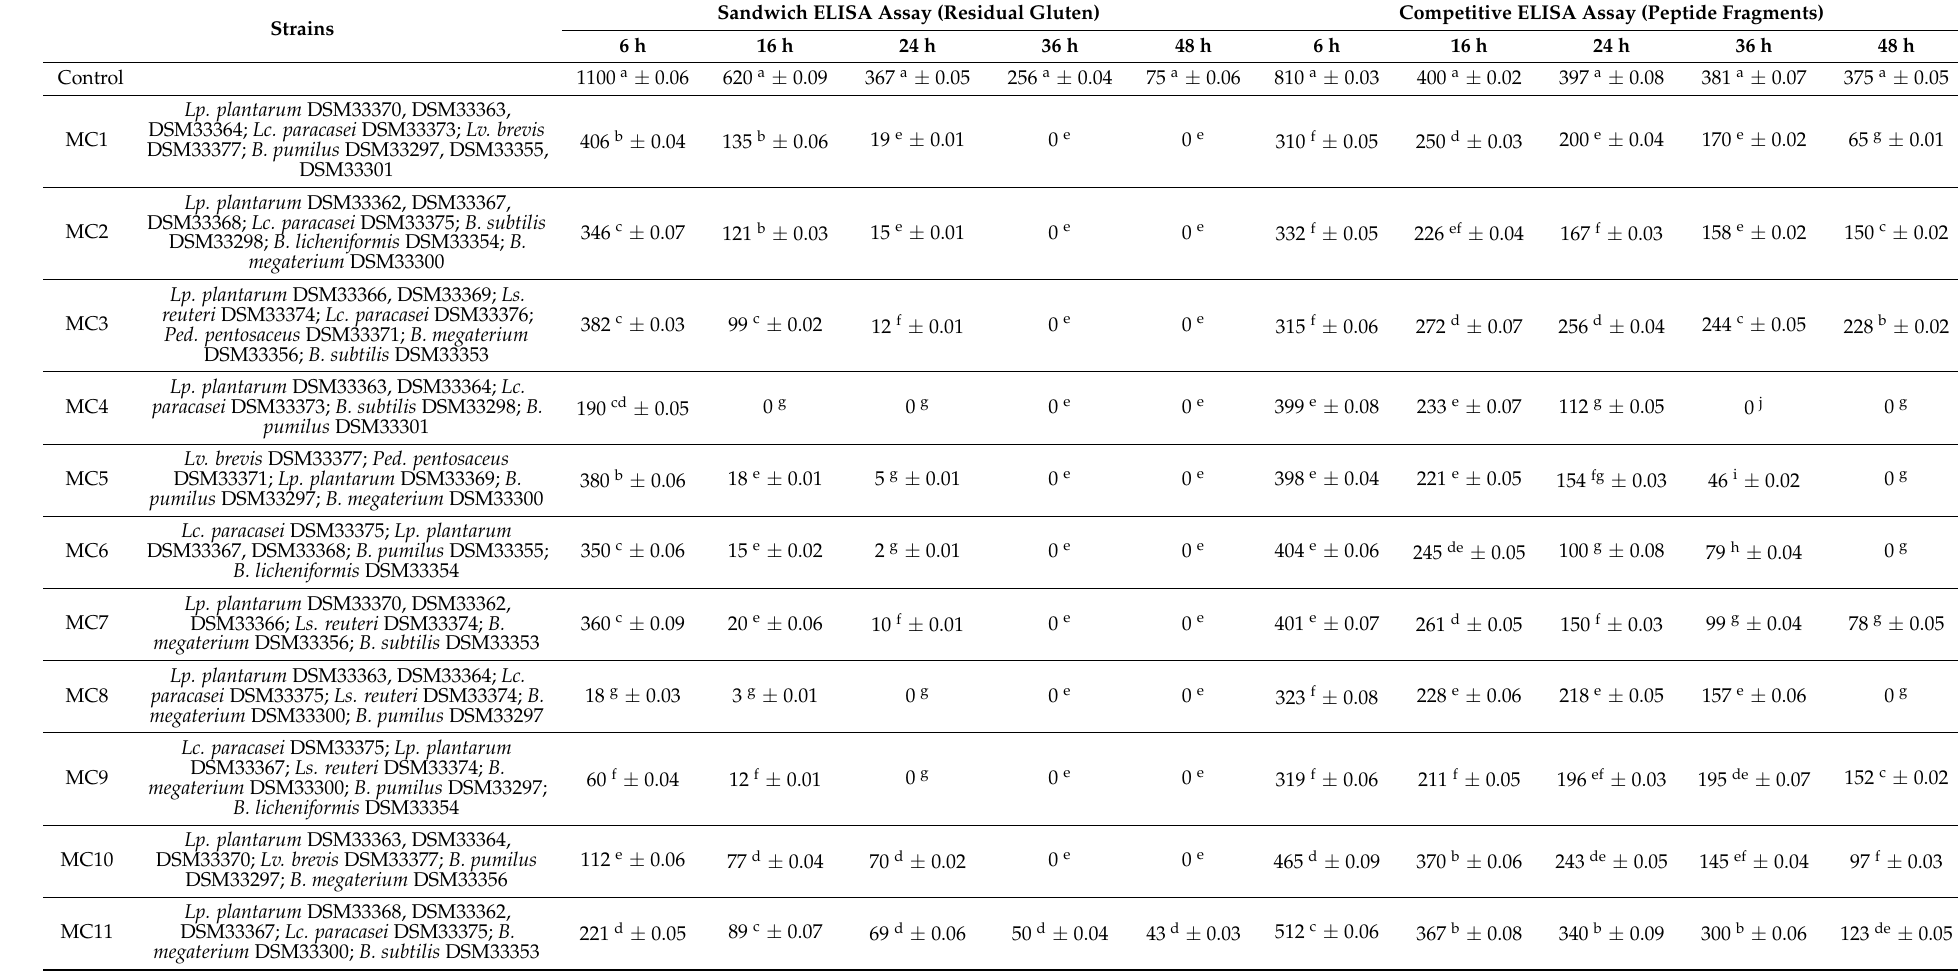
Table 1. Concentration (ppm) of residual gluten and peptide fragments of prolamins after 6, 16, 24, 36, and 48 h of simulated gastrointestinal digestion, as estimated by specific ELISA tests. Control: dough digested without bacterial cells and commercial enzymes; MC1–MC16: microbial consortia constructed by using live and lysed cells of selected lactobacilli ( Lactiplantibacillus , Lp .; Lacticaseibacillus , Lc .; Levilactobacillus , Lv .; Limosilactobacillus , Ls ., Fructilactobacillus , Fr .; Pediococcus , Ped .) and Bacillus (B.) strains and E1, E2, Veron PS, and Veron HPP commercial